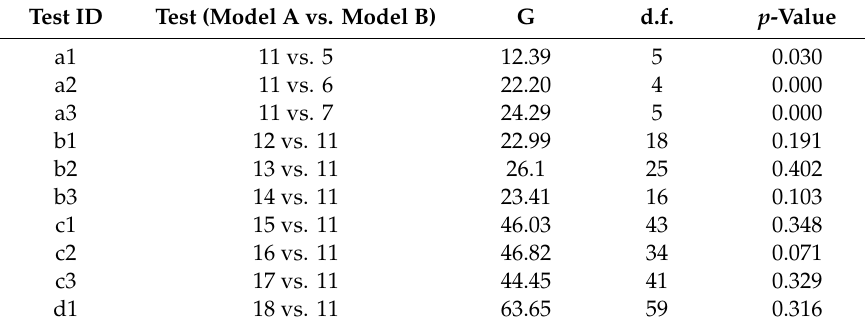
Table 3. Model comparisons.